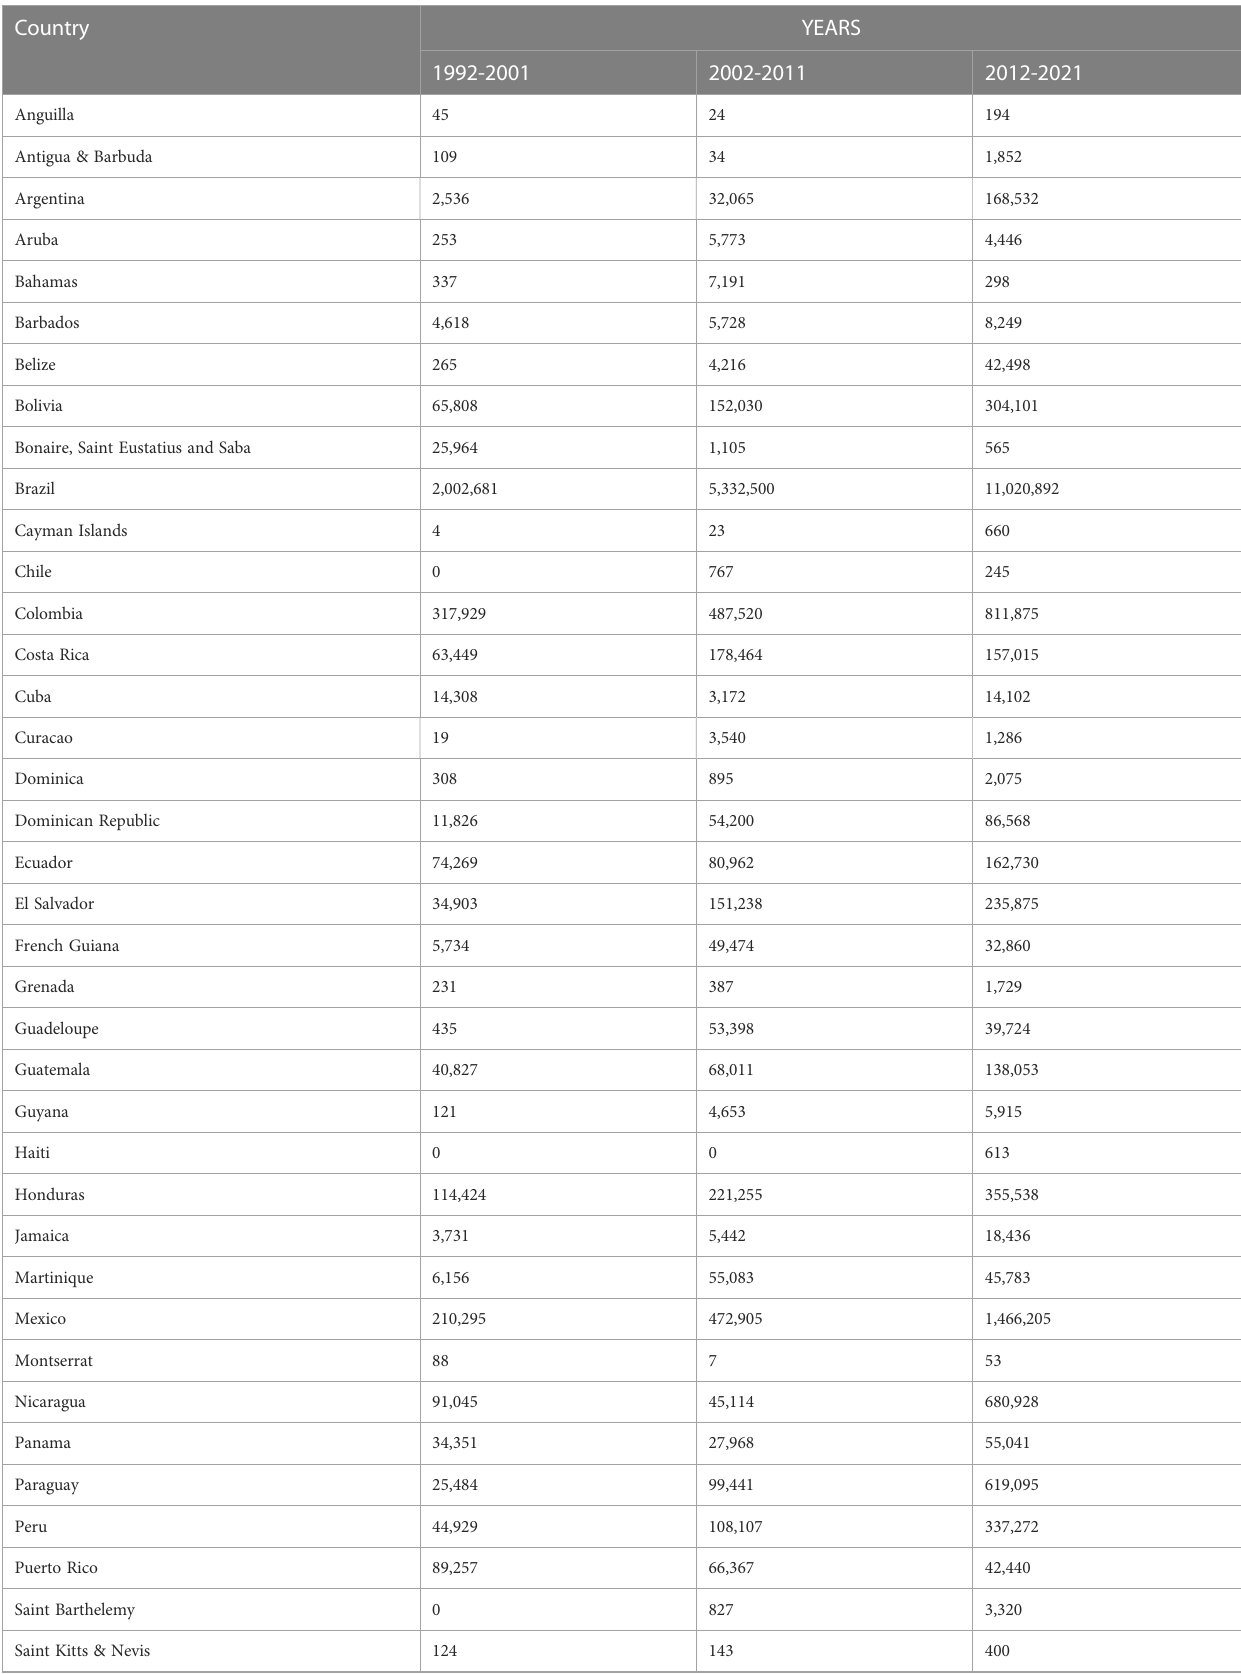
TABLE 1 Reported cases of dengue in the LAC region over the past 3 decades